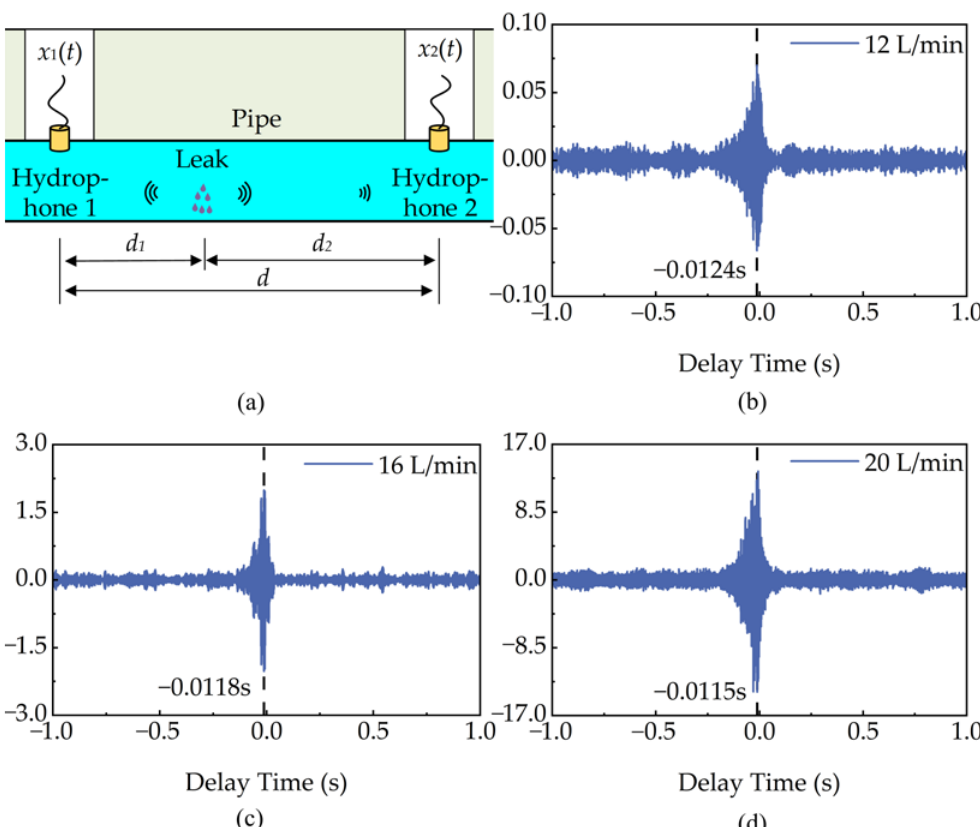
Figure 10. The cross-correlation localization: ( a ) Schematic diagram showing MEMS hydrophones deployment for pipeline leak detection, ( b ) leak delay of 12 L/min, ( c ) leak delay of 16 L/min, ( d ) leak delay of 20 L/min.